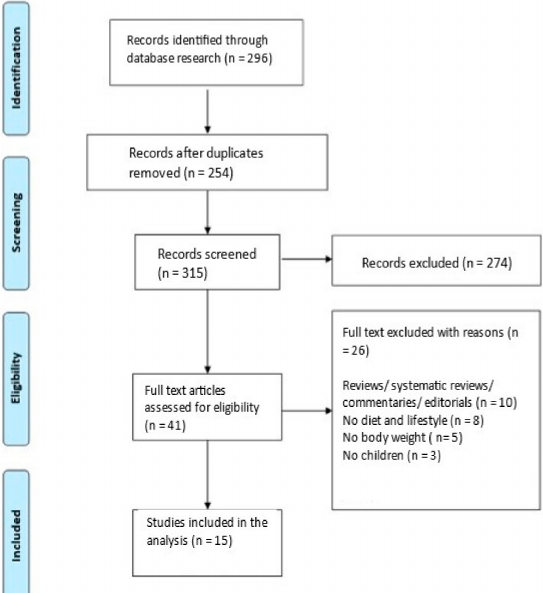
Figure 1. PRISMA flow chart of included